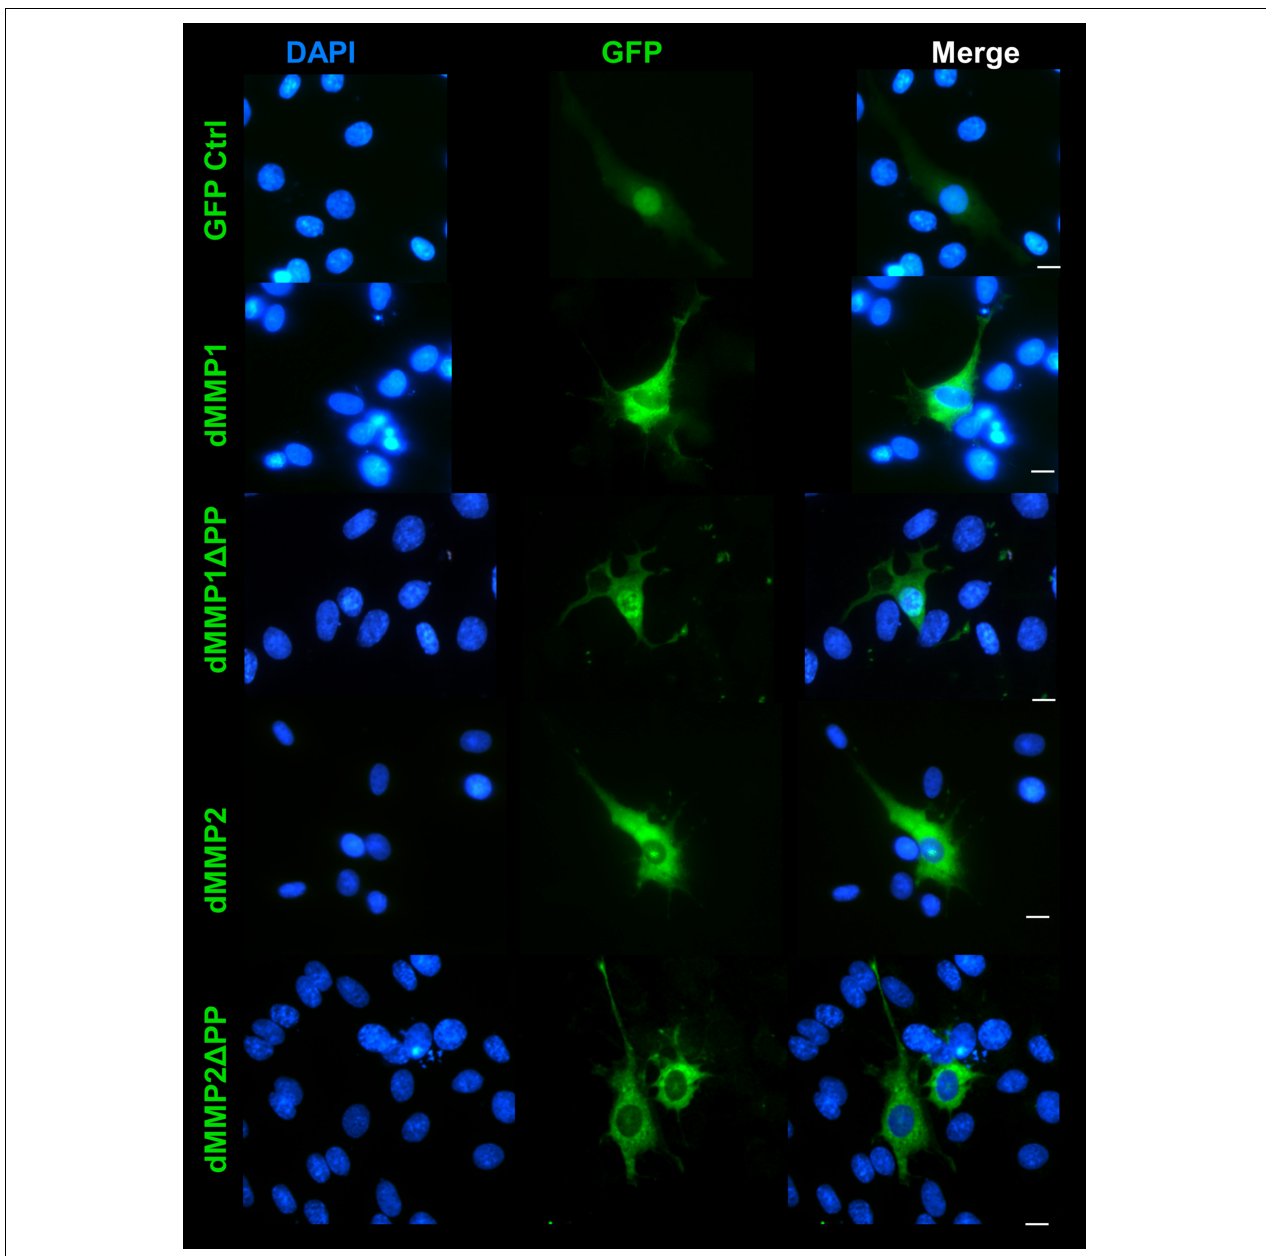
FIGURE 7 | GFP-dMMP localization in glial cells. Transfection of C6 cells with GFP-dMMPs and GFP alone, using Fugene 6, and localization patterns of GFP at 24 hrs post-transfection. GFP Control localized to the nucleus and cytoplasm whereas GFP-dMMP constructs localized differentially in C6 glial cells. Shown in blue is DAPI nuclear stain. Shown in green are the various GFP constructs compared to GFP control. Scale bar = 10 µ